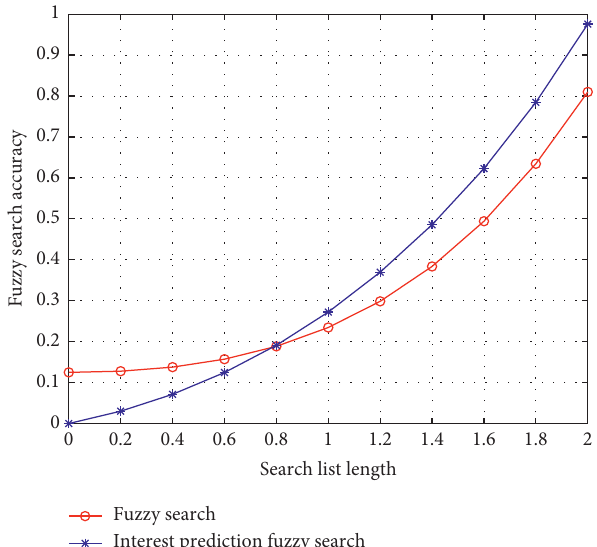
Figure 8: The discriminative search accuracy of fuzzy English grammar after interest prediction.